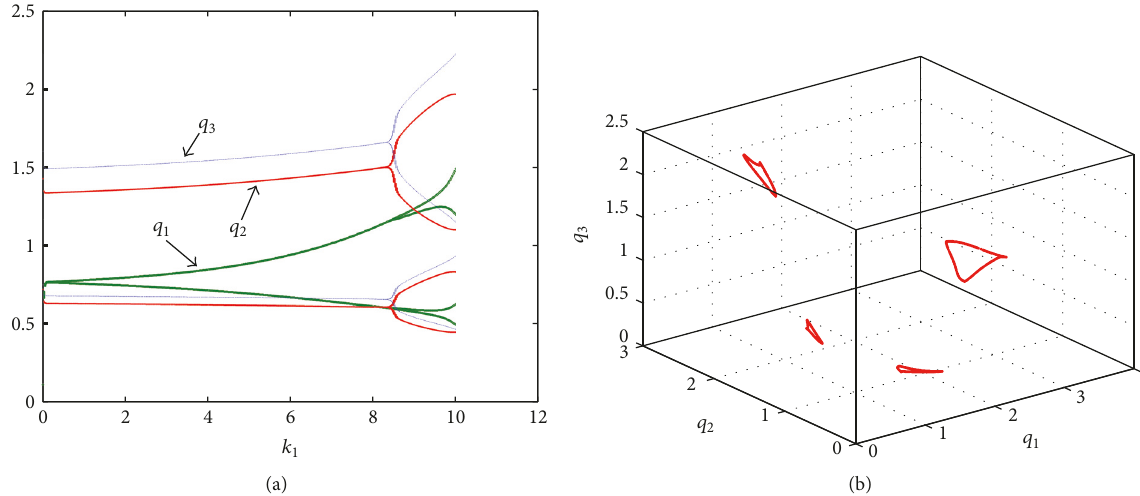
Figure 11: (a) Bifurcation diagram for the case (𝛼 = 0.7) with respect to 𝑘 1 at 𝑐 1 = 0.19 , 𝑐 2 = 0.18 , 𝑐 3 = 0.17 , 𝑞 0,1 = 0.11 , 𝑞 0,2 = 0.12 , and 𝑞 = 0.13 . (b) The phase portrait at 𝑘 3,0